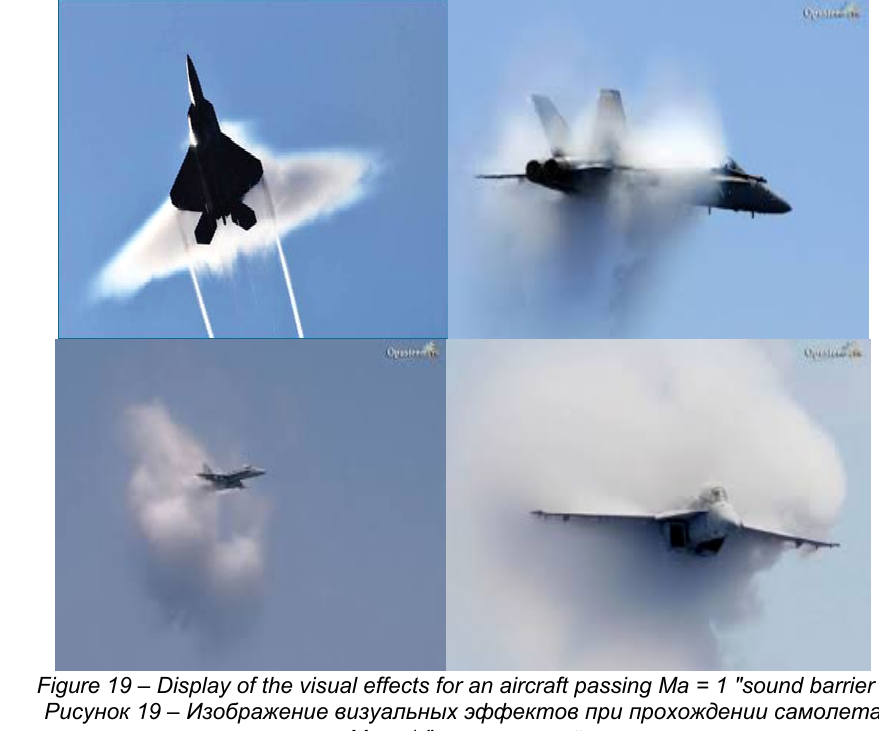
Figure 19 – Display of the visual effects for an aircraft passing Ma = 1 "sound barrier  Рисунок 19 – Изображение визуальных эффектов при прохождении самолета Ма = 1 " стена звука